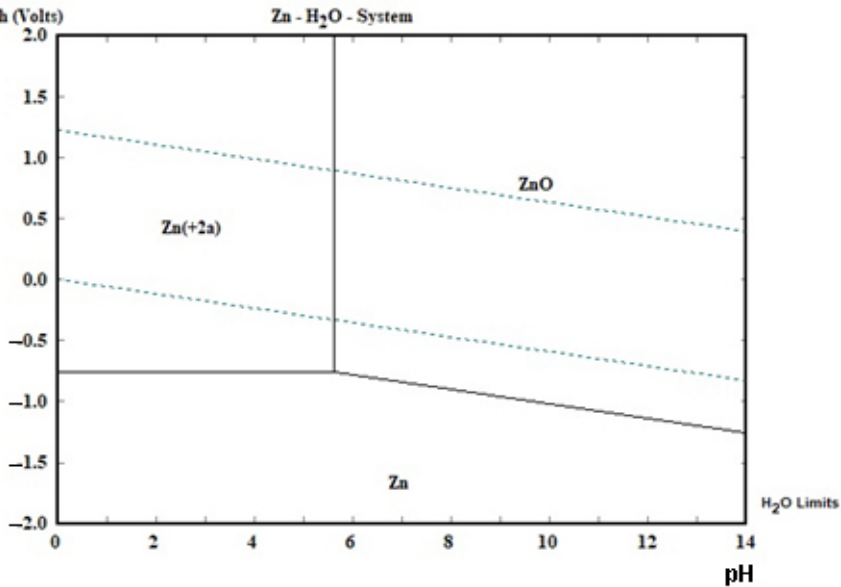
Figure 4. The potential—pH diagram for Zn-H 2 O system at 25 ◦ C and 1 bar for molality 1 mol · kg − 1 H 2 O [33].